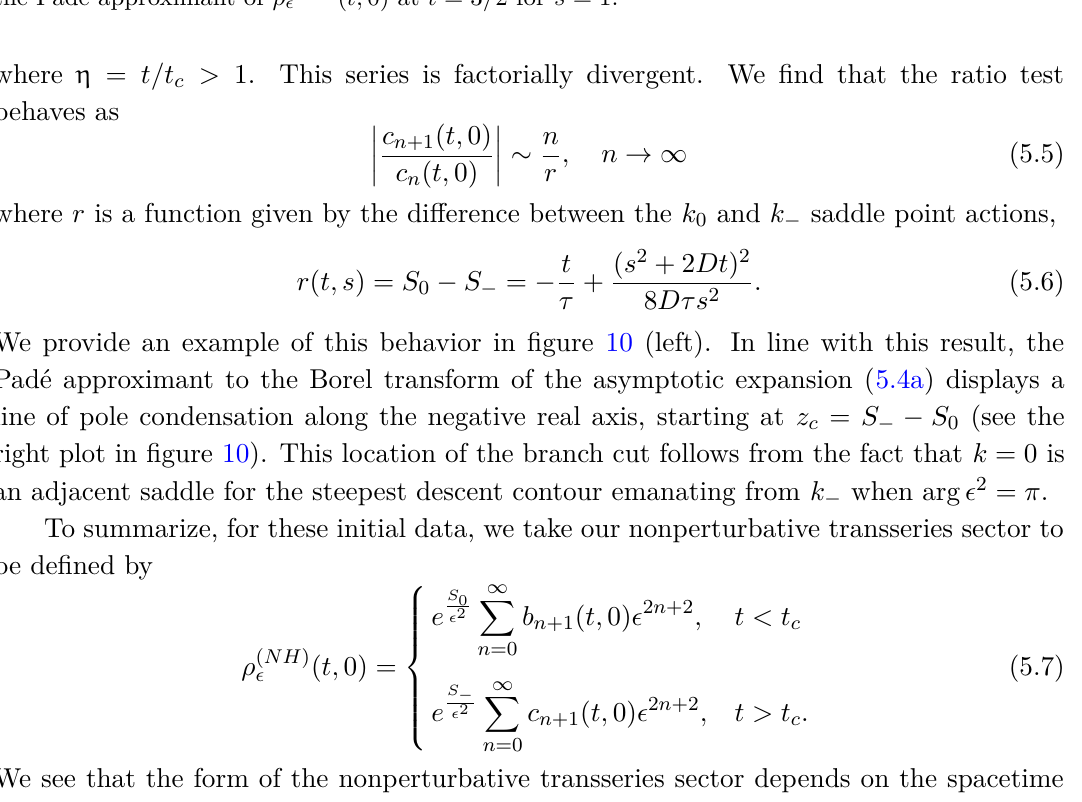
Figure 10 . Left: for s = 1 , r as a function of t as determined directly from the closed-form expression for c ( t, 0) (open red circles) vs. the function S (solid blue line). Right: poles of n 0 − S − the Padé approximant of ρ ( NH ) ( t, 0) at t = 3 / 2 for s = 1 (cid:15)